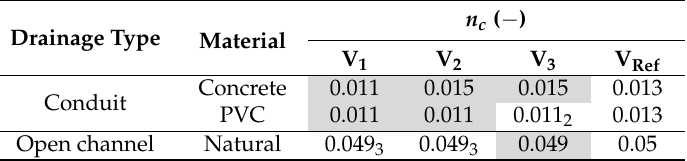
Table 4. The parameter sets V 1 , V 2 , V 3 , and V Ref for the Manning’s roughness for conduit flow n c . Calibrated parameter values have a grey background, un-calibrated values have a white background and the subscripts 1–3 indicate from which study catchment values were adopted if corresponding surfaces were missing. Parameter values of V Ref were derived from Rossman